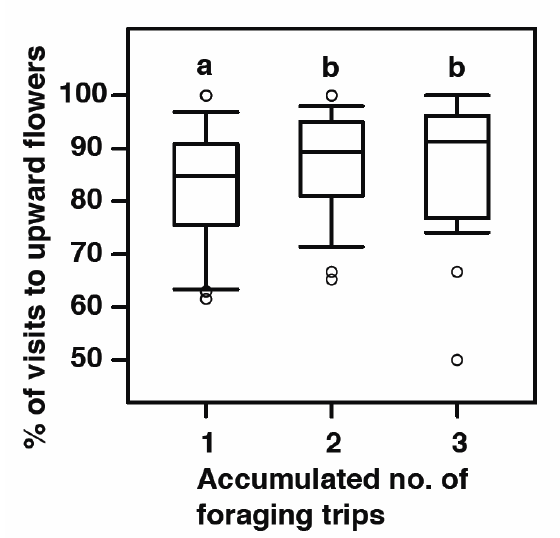
F IG . 3. Box-and-whisker plot of the percentage of visits to upward-facing flowers. The band in a box, the bottom and the top of the box, and the ends of the whiskers represents median, the 25 th , 75 th , 10 th and 90 th percentile, respectively ( n = 24 bees). Small circles are outliers. Different letters indicate significant difference between foraging trips at sequential Bonferroni-adjusted alpha levels with statistical significance determined at P =